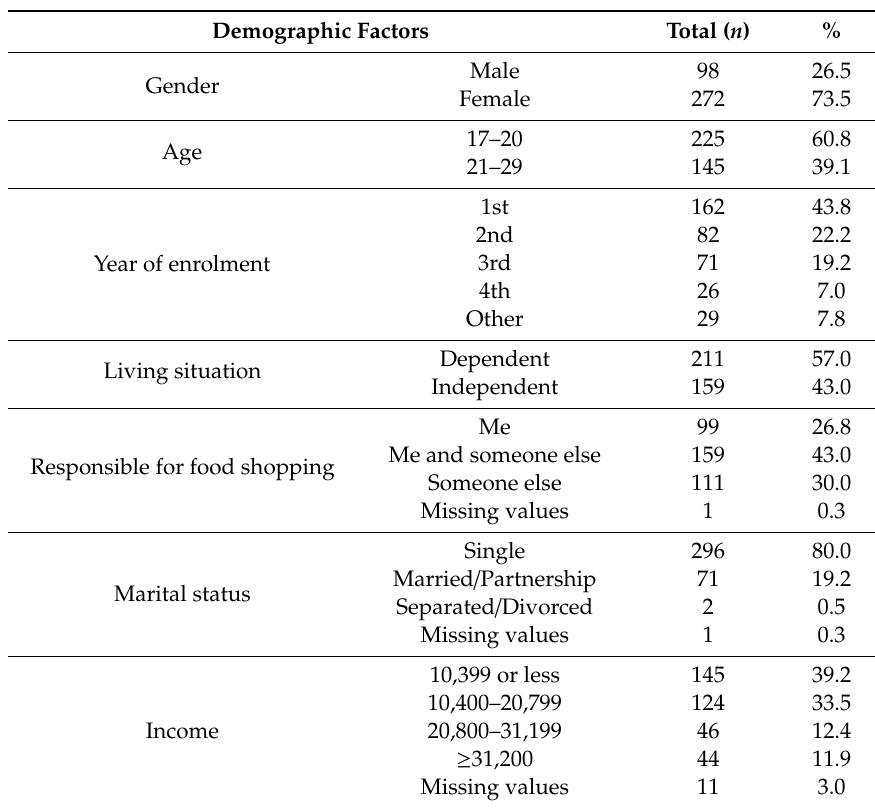
Table 1. Demographic characteristics of the